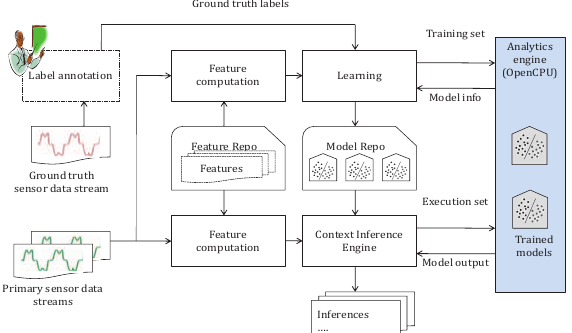
Figure 3: The workflow of the Context Inference Engine for train- ing and execution